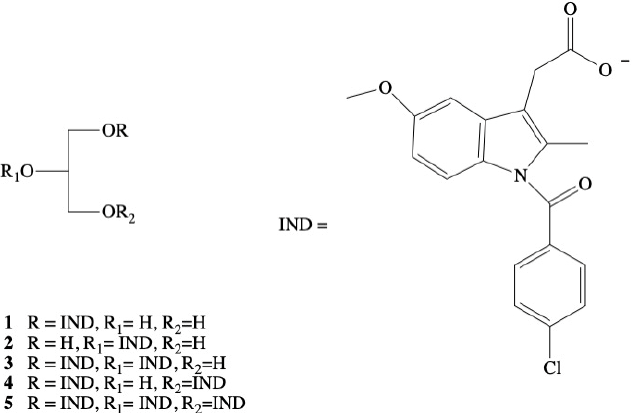
Figure 3. Chemical structure of triacylglycerides containing indomethacin 1 – 5 .